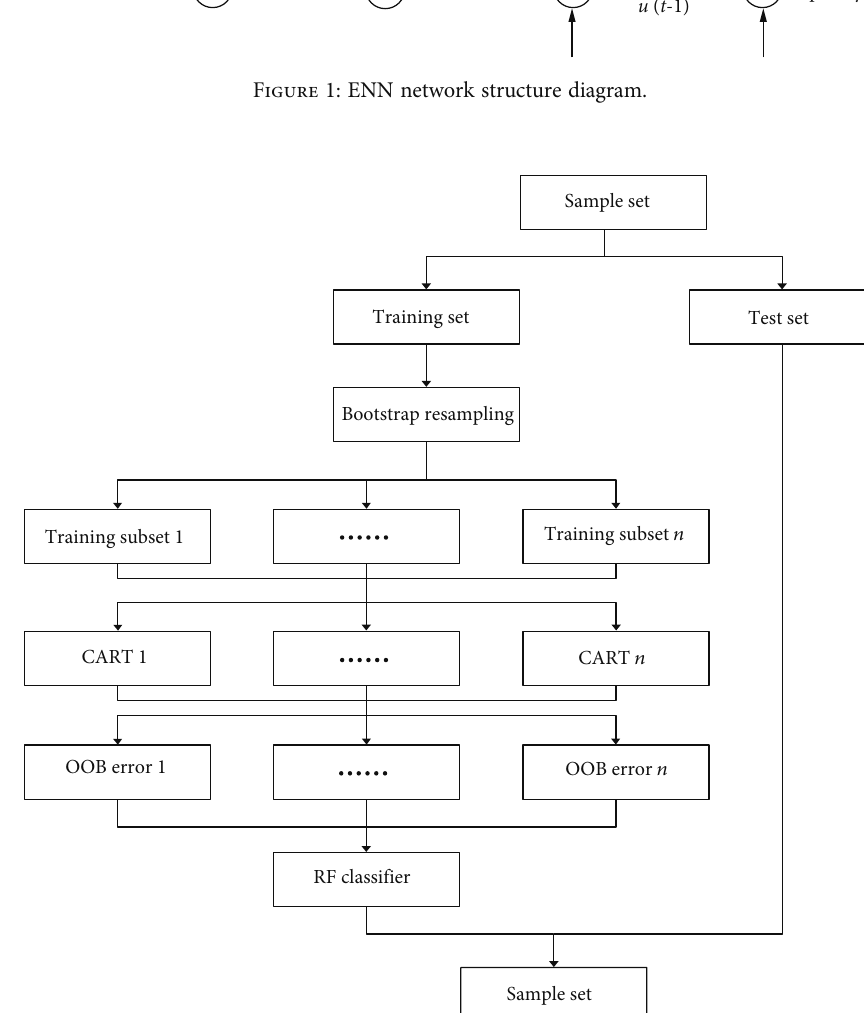
Figure 2: RF feature selection fl ow